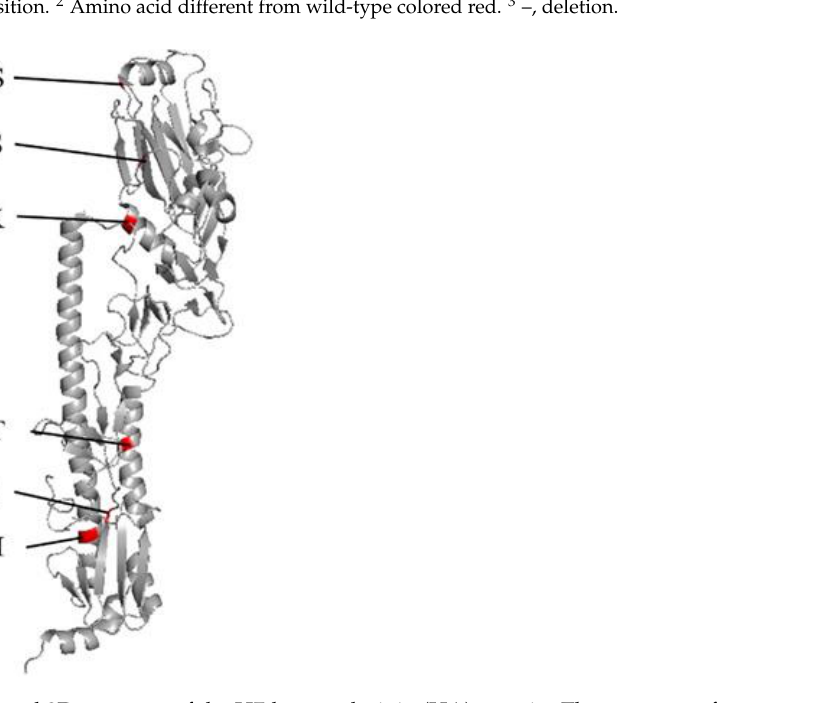
Figure 2. Predicted 3D structure of the H7-hemagglutinin (HA) protein. The structure of monomeric HA from A/environment/New York/30732-1/2005(H7N2) (PDB: 3M5J) is shown. Mutations found in A549-adapted viruses are colored in red.